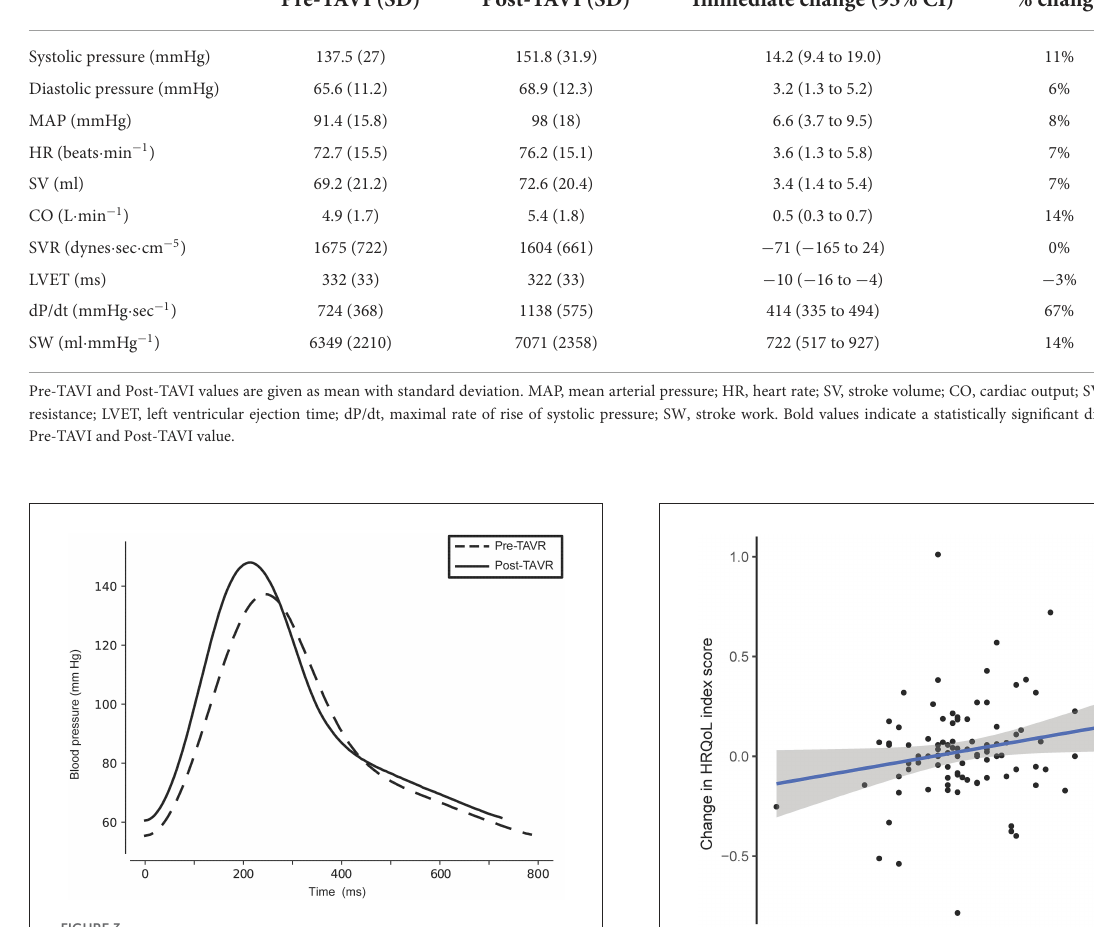
FIGURE3 Visualization of the immediate blood pressure waveform change following TAVI. To compose this figure, waveform data of a representative patient was used, whose changes were in line with the average change of the studied population. Pre- (dashed) and Post-TAVI (solid) waveforms were composed by selecting the first 15 beats of each respective time window, trimmed to have the same duration and finally averaged.